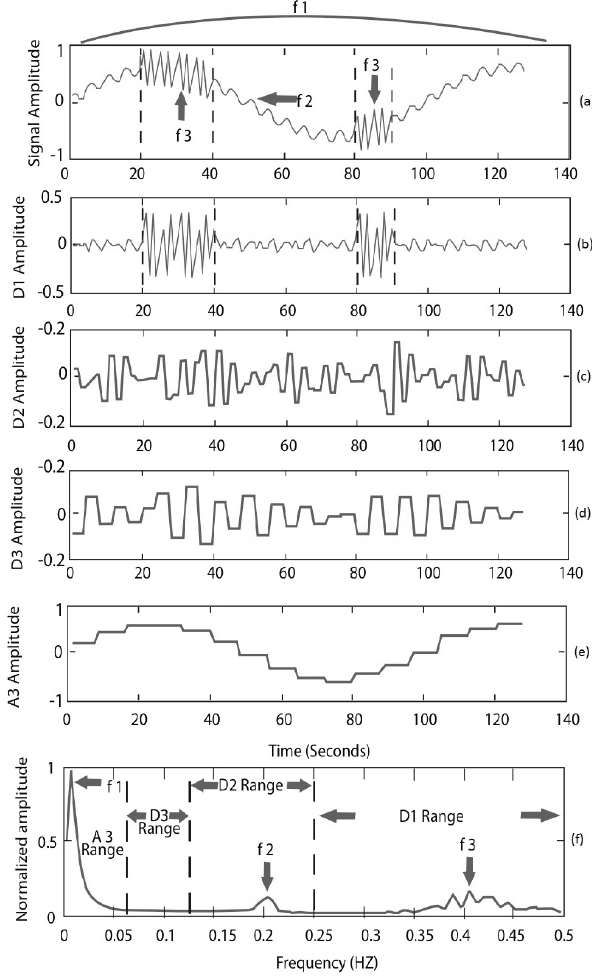
Fig. 1. Comparison between FFT Power spectrum and DWT time- frequency decomposition analysis, for a synthetically generated ULF transient